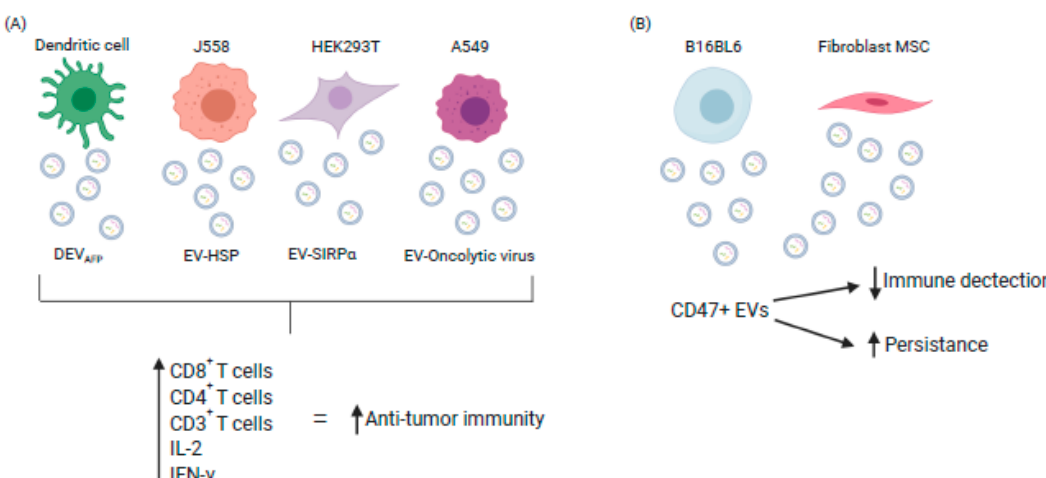
Figure 1. Exploiting EV characteristics to enhance or evade immune response ( A ) Engineered EVs stimulate immune cell infiltration into tumors and disease regression ( B ) CD47 + ve EVs evade host immunity resulting in increased persistence and improved therapeutic response. (DEV-AFP: Dendritic EV α -fetaprotein; HSP: Heat Shock Protein; IL: Interleukin; IFN: Interferon. (Image created using Biorender.com—paid subscription).